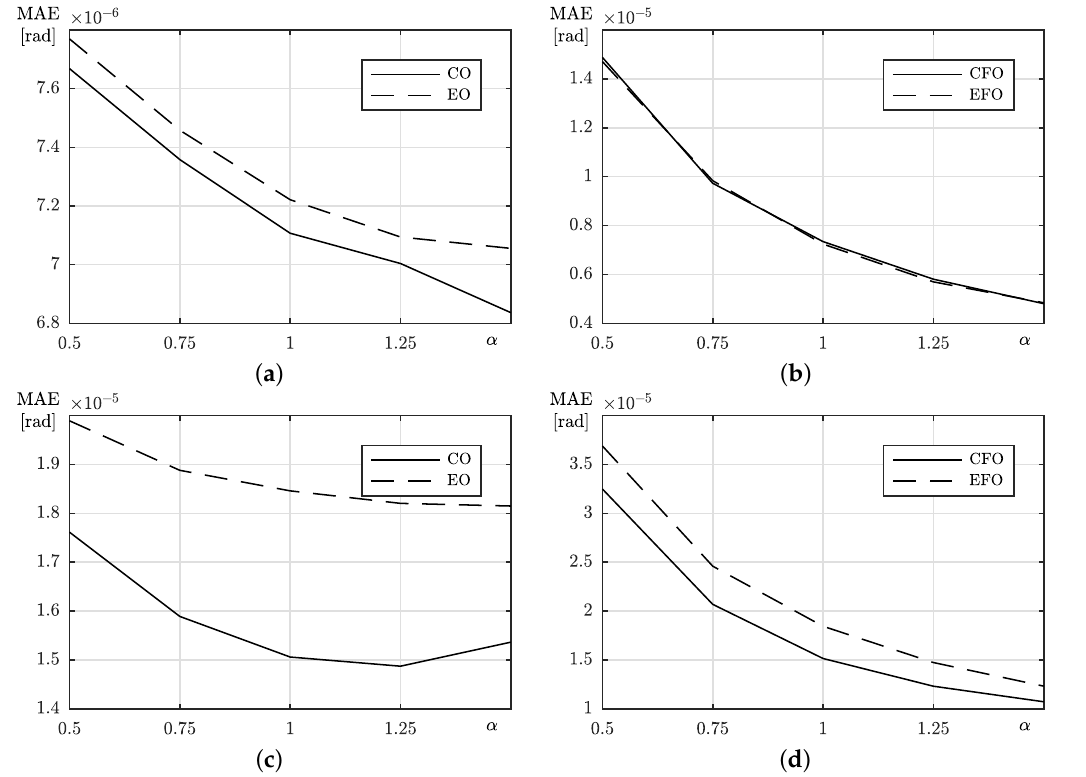
Figure 7. A comparison of the steady-state tracking error: ( a , b ) slow trajectory, ( c , d ) fast